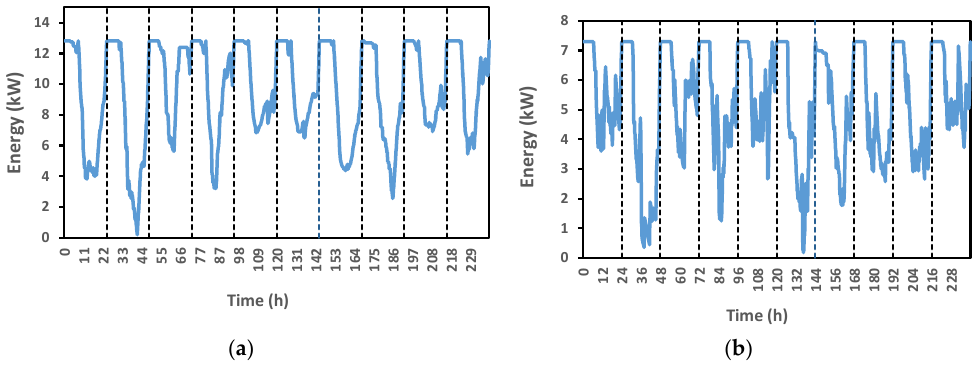
( a ) ( b ) Figure 9. TES discharge profile for incentivised design: ( a ) detached house; ( b )